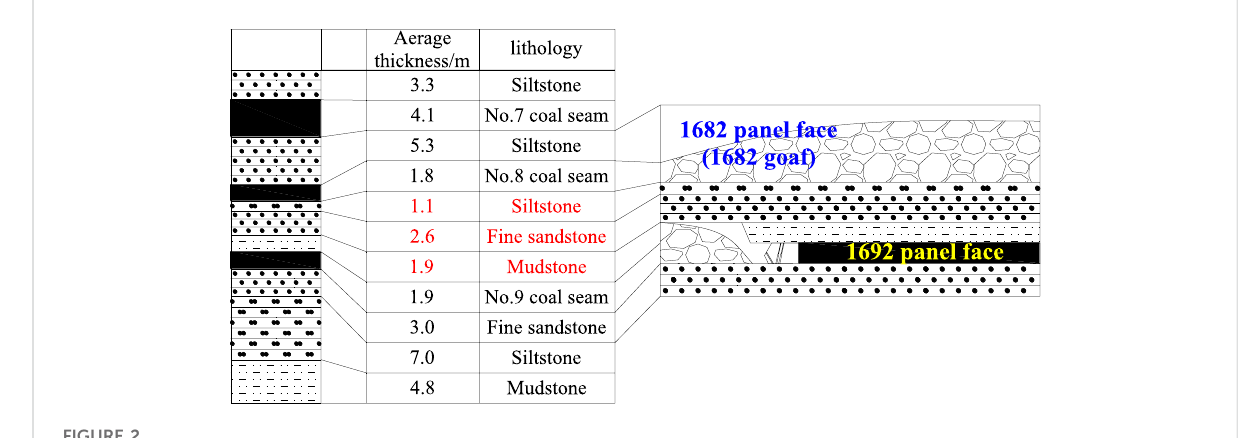
FIGURE 2 Column of rock mass and coal seam.